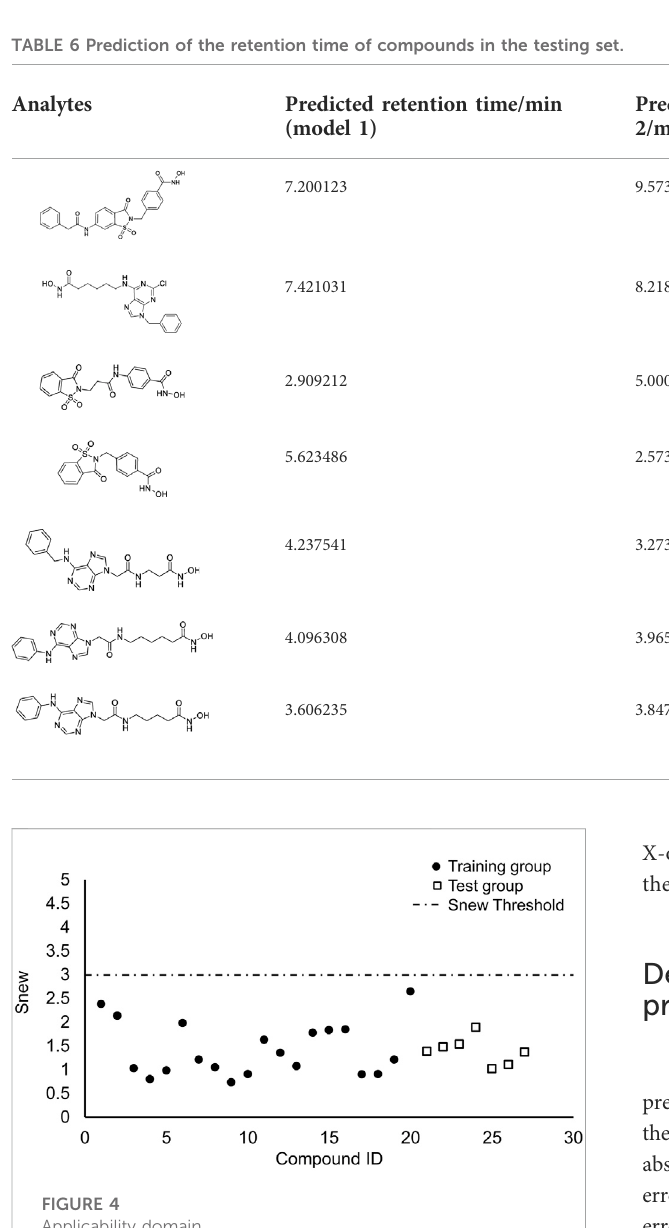
FIGURE 4 Applicability